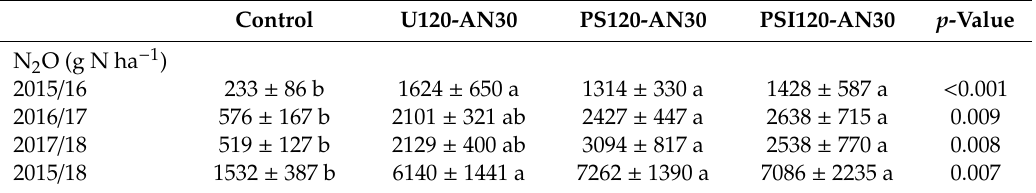
Table 5. Nitrous oxide emission (g N ha − 1 ; mean ± standard error; n = 4) in the four treatments (control, U120-AN30, PS120-AN30, and PSI120-AN30) for the three years (from sowing to the following sowing in 2015 / 16, 2016 / 17, and 2017 / 18) and the whole experiment (2015 / 18). Di ff erent letters in the same row indicate significant di ff erences between treatments (Tukey’s test; p < 0.05). Control U120-AN30 PS120-AN30 PSI120-AN30 p -Value N 2 O (g N ha − 1 )